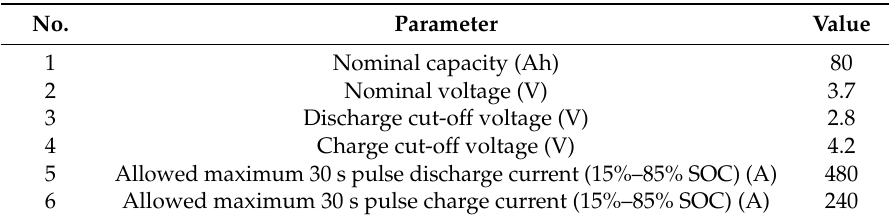
Table 1. Basic information of the battery cell provided by the supplier.